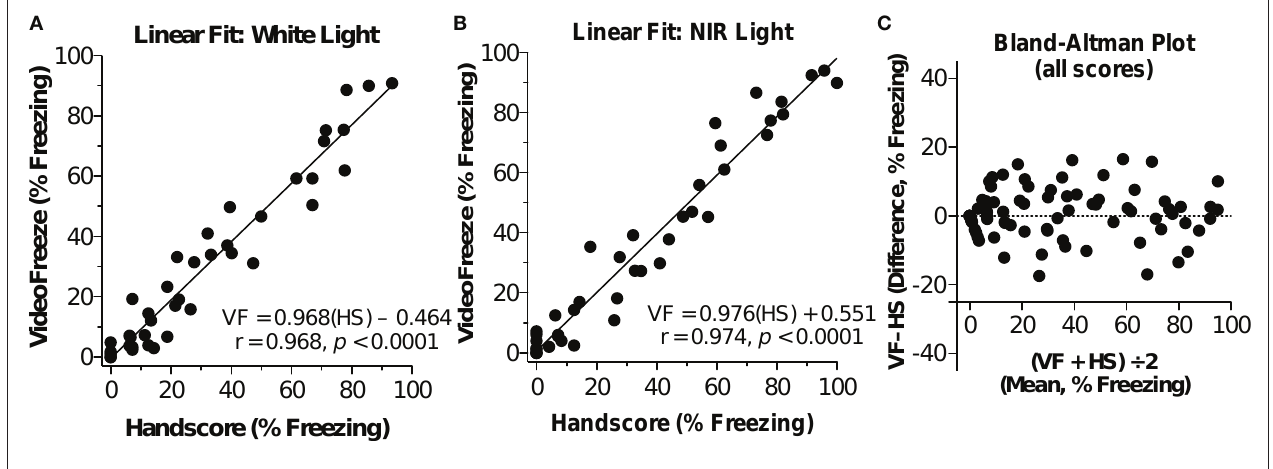
Figure 3 | Linear fit and correlation for (18,30). (A) White Light. The linear fit between computer (VideoFreeze, VF) and human (Handscore, HS) scored freezing is depicted for the white light condition. (B) NIR light. The linear fit is depicted for the NIR light condition. In both cases, a nearly perfect fit and